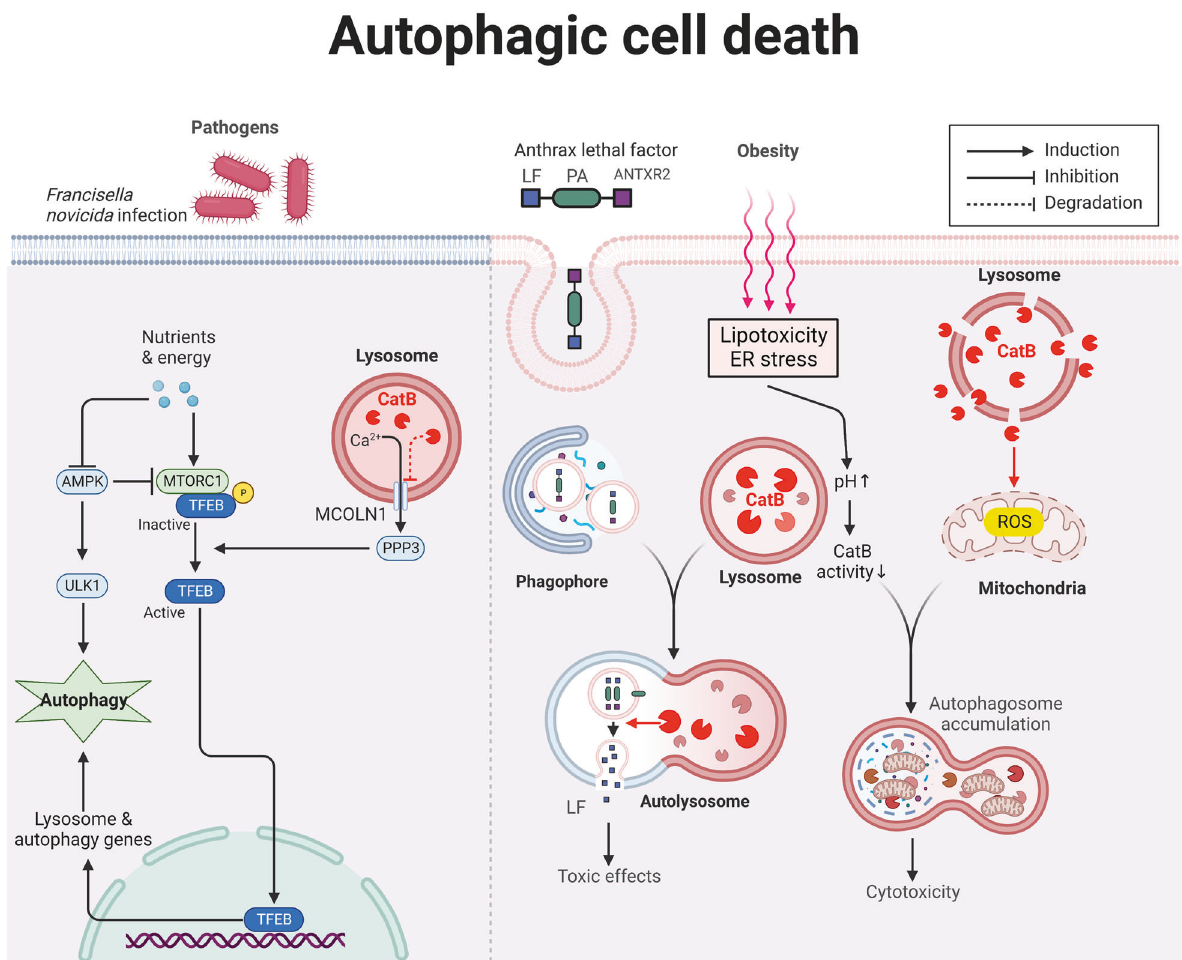
Fig. 6 Schematic representation of CatB and its substrates in autophagy. Loss of growth factor stimulation or nutritional inputs like glucose leads to the activation of the ULK complex and subsequently drives phagophore assembly. The phagophore elongates and circularizes to form the autophagosome, which then docks with lysosomes. Under homeostatic conditions, CatB directly cleaves the lysosomal calcium channel MCOLN1 and negatively regulates the ef fl ux of calcium and activation of the PPP3. Inhibition of PPP3 prevents its ability to dephosphorylate and activate TFEB. Dephosphorylated TFEB initiates autophagy. Therefore, CatB works as an apical signal controlling lysosomal dynamics and autophagy. ANTXR2-mediated delivery of LF requires autophagy fl ux, which is triggered by lysosome fusion and CatB. Obesity-induced lipotoxicity and ER stress, or stressed lysosomal mediated autophagosome accumulation involves CatB activity reduction or lysosomal leakage. AMPK AMP-activated protein kinase, ANTXR2 anthrax toxin receptor 2, CatB cathepsin B, ER endoplasmic reticulum, LF lethal factor, MCOLN1 mucolipin TRP cation channel 1, PPP3 Protein Phosphatase 3, TFEB transcription factor EB, ULK Unc-51 like autophagy activating